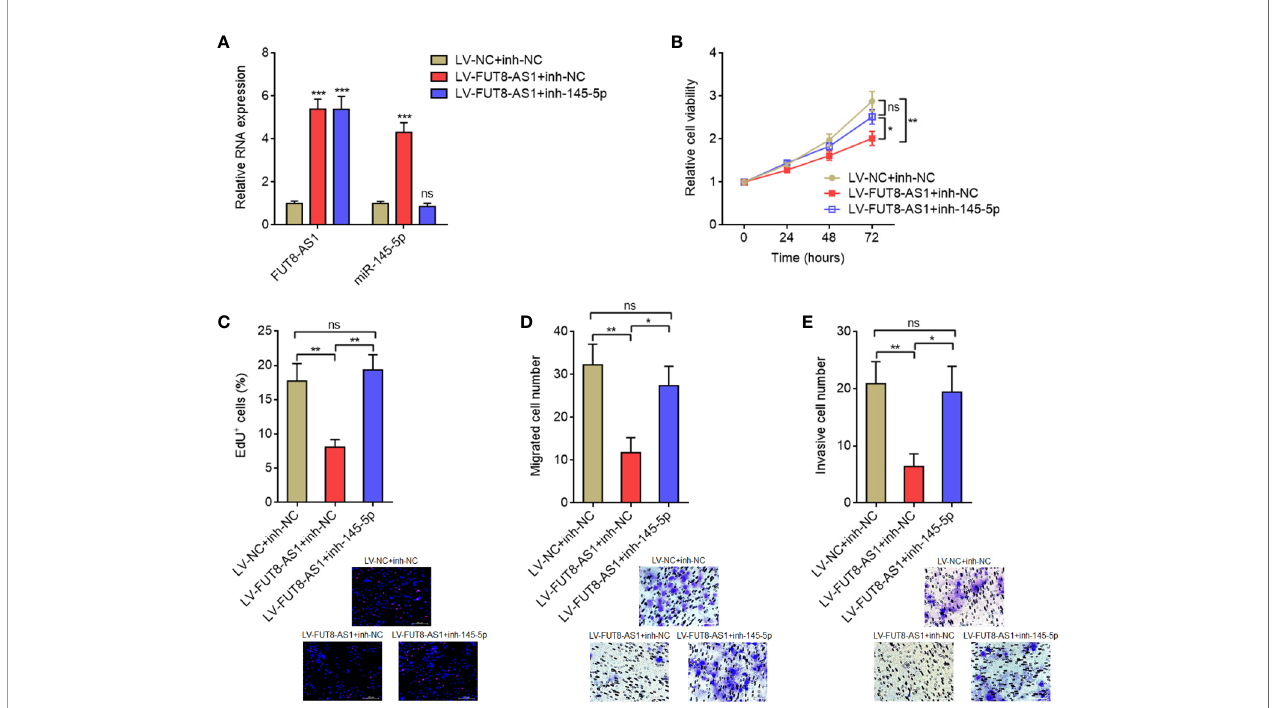
FIGURE 7 | miR-145-5p inhibition reversed the tumor suppressive roles of FUT8-AS1 in melanoma. (A) FUT8-AS1 and miR-145-5p expression levels in CHL-1 cells overexpressing FUT8-AS1 and concurrently silencing miR-145-5p were measured by real-time PCR. (B) Cell viabilities of CHL-1 cells overexpressing FUT8-AS1 and concurrently silencing miR-145-5p were determined by the Glo cell viability assay. (C) Cell proliferation of CHL-1 cells overexpressing FUT8-AS1 and concurrently silencing miR-145-5p were determined by the EdU incorporation assay. The red color indicates EdU-positive nuclei. Scale bars, 200 µm. (D) Cell migration of CHL-1 cells overexpressing FUT8-AS1 and concurrently silencing miR-145-5p were determined by the transwell migration assay. Scale bars, 100 µm. (E) Cell invasion of CHL-1 cells overexpressing FUT8-AS1 and concurrently silencing miR-145-5p were determined by the transwell invasion assay. Scale bars, 100 µm. Data are presented as mean ± SD. * P < 0.05, ** P < 0.01, *** P < 0.001; ns, not signi fi cant, by one-way ANOVA followed by Tukey ’ s multiple comparisons